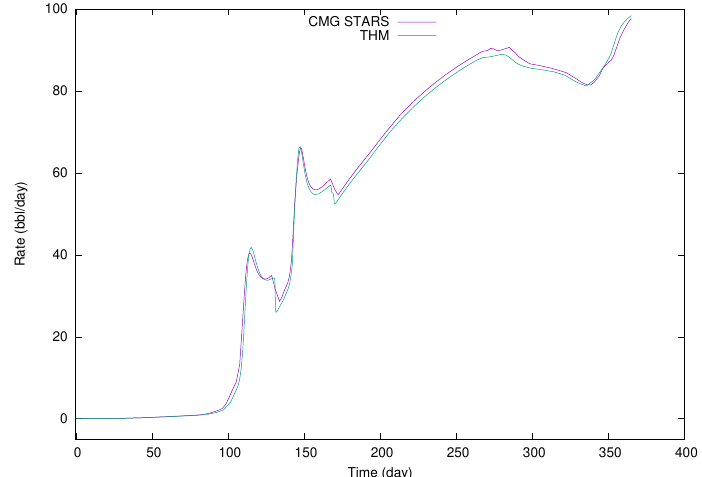
Figure 5. Example 1, total water production rate (bbl/day).